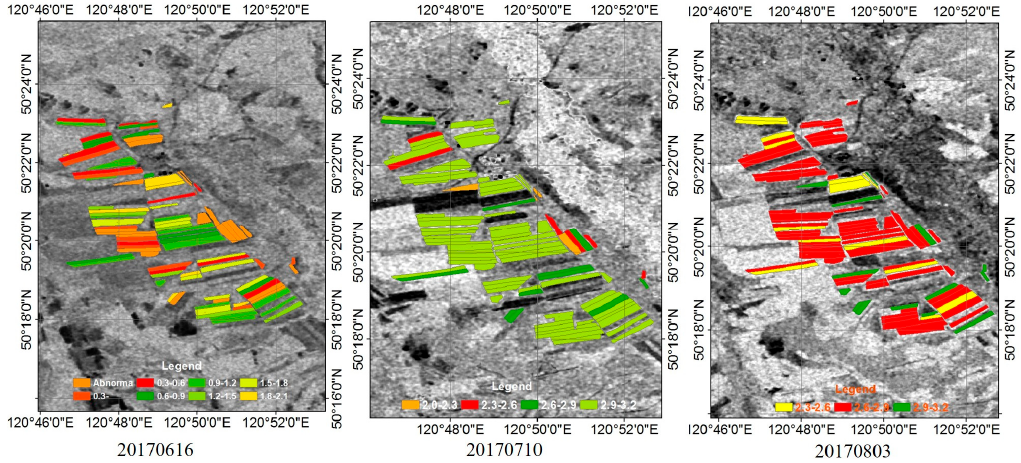
Figure 7. The leaf area index (LAI) of 95 rape plots, with a background image of the radar vegetation index (RVI) (Cloude). 20170616 is the estimation result of P2, 20170710 is the estimation result of P3, and 20170803 is the estimation result of P4. All of the results were estimated by y = − 22.106x 2 + 33.756x − 9.7948 with RVI (Cloude). Table 10 . The proportion of plots within each estimation error range for leaf area index (LAI) at each stage.